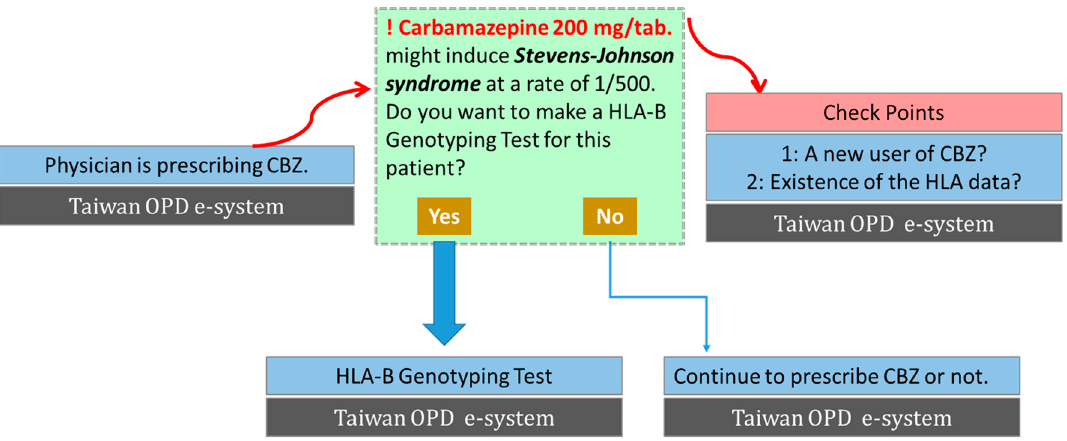
Figure 1. Flowchart of the risky allele screening prior to prescription, an electronic system alert example of carbamazepine (CBZ) prescription at medical centers in Taiwan. HLA: human leukocyte antigen; OPD: out-patient department.